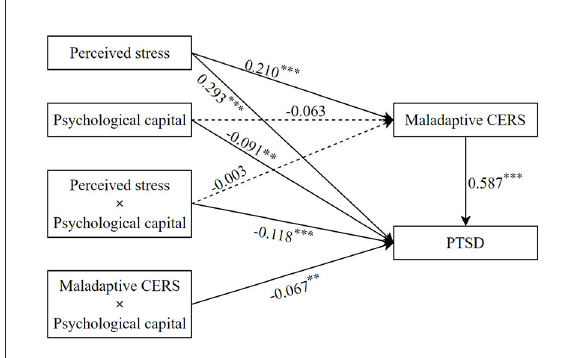
FIGURE3 The moderating effect of psychological capital on the relationship between perceived stress and PTSD symptoms. ** p < 0.01; *** p < 0.001.